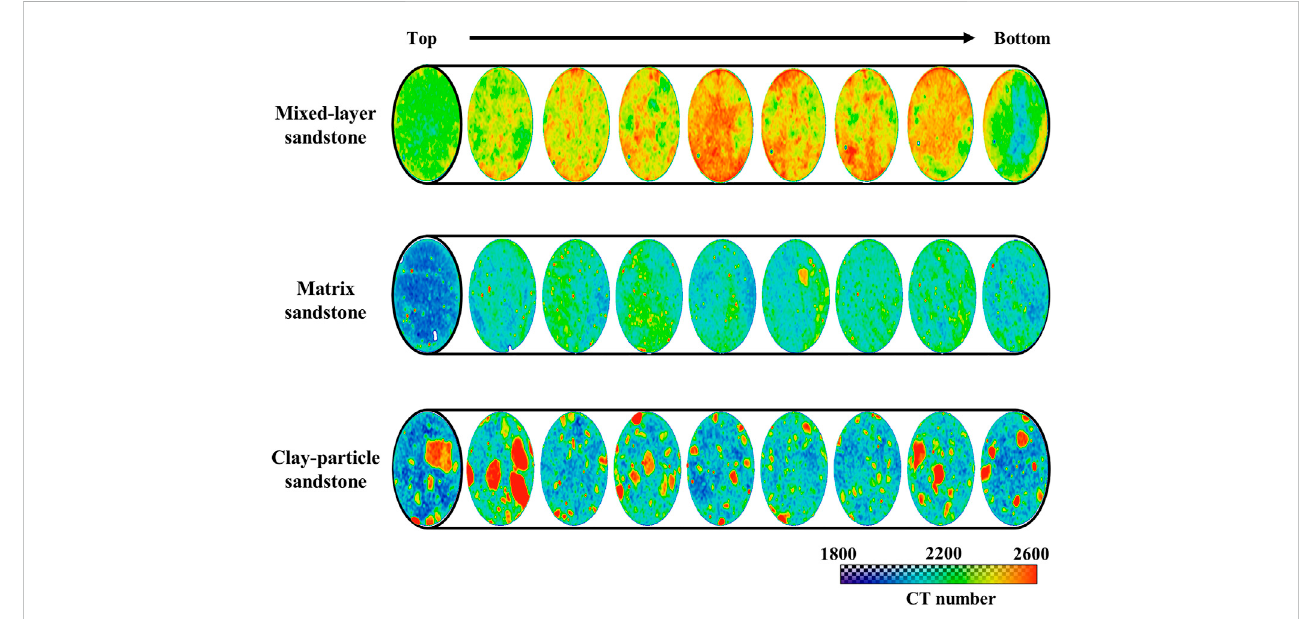
FIGURE 3 CT scanning slices in different positions for different cores.